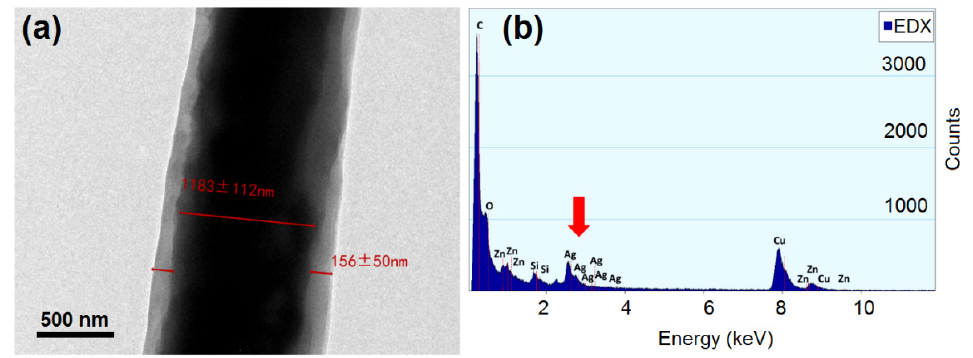
Figure 5. Internal structure and element analysis of the coaxial fiber: ( a ) TEM image of the coaxial nanofiber structure; ( b ) EDX energy spectrum of the coaxial fiber.